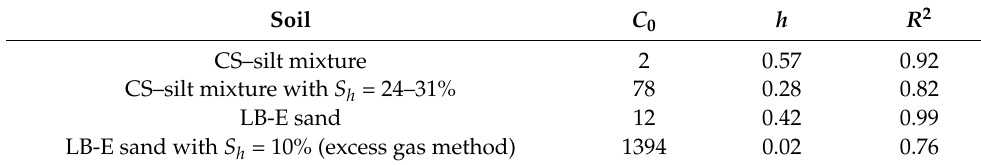
Table 3. Best-fit values of the model parameters for Equation (2).